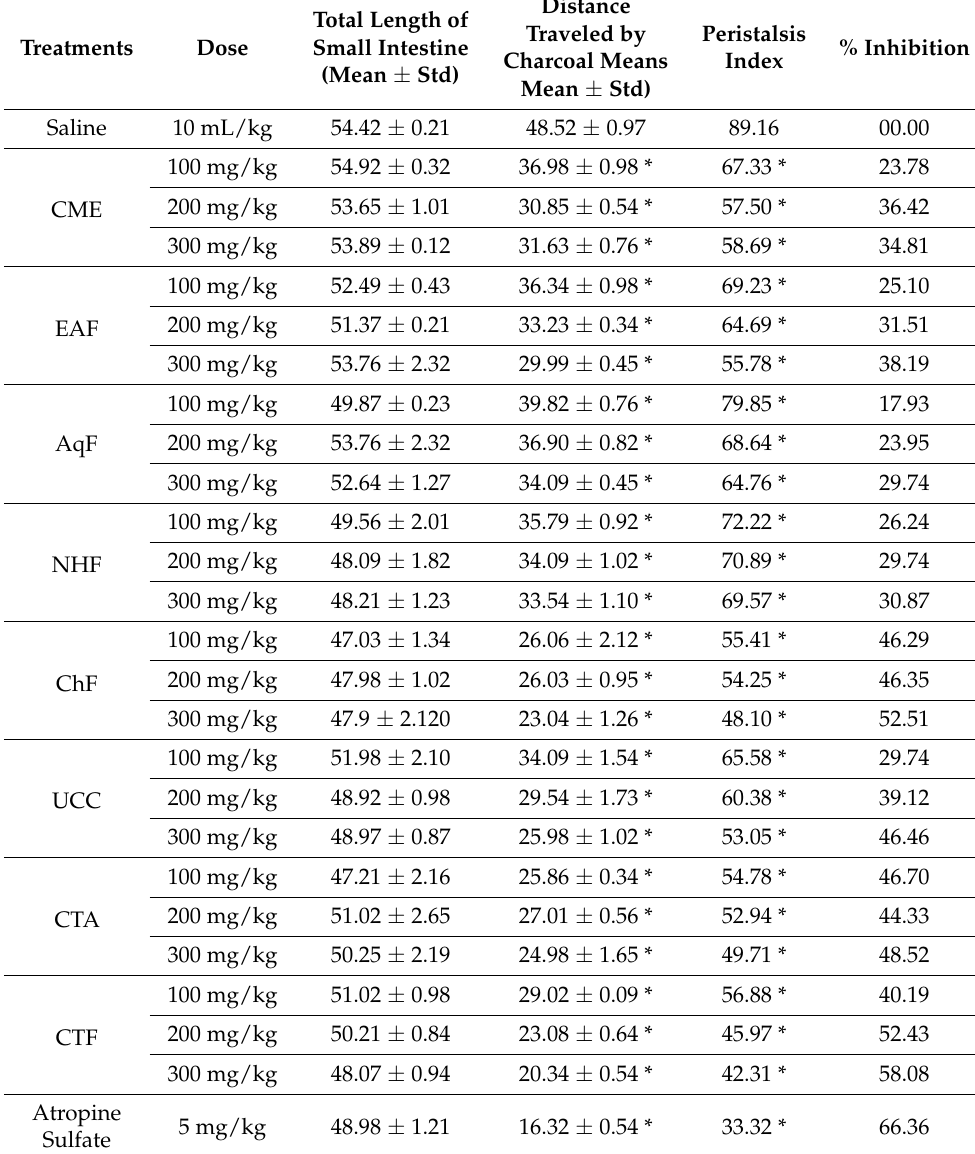
Table 2. The antidiarrheal potential of V. canescens in the charcoal meal assay. Treatments Dose